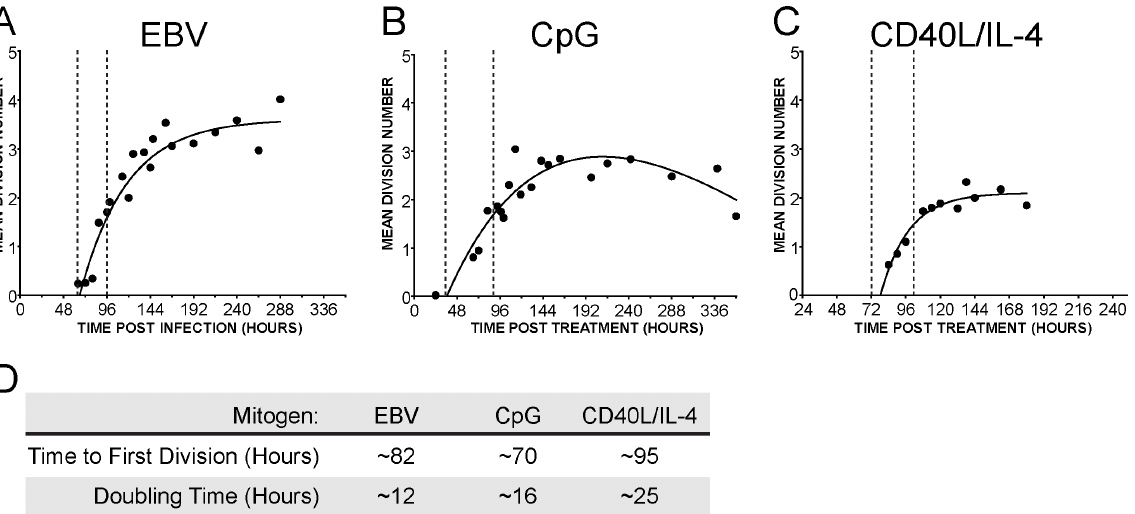
Figure 1. Multiple B-cell mitogens induce an initial burst of hyper-proliferation. Kinetics of B cell proliferation in response to (A) Epstein- Barr virus infection, (B) constant stimulation with TLR9 ligand CpG (2.5 m g/mL), or (C) CD40L (5 ng/mL) coupled with interleukin-4 (20 pg/mL) treatment. The mean division number based on precursor cohort analysis [42] and plotted over time post infection or treatment is shown. Vertical dashed lines indicate the period of hyper proliferation. (D) The mean division number and time to first division was calculated as in [24,27] for the period of hyper-proliferation.